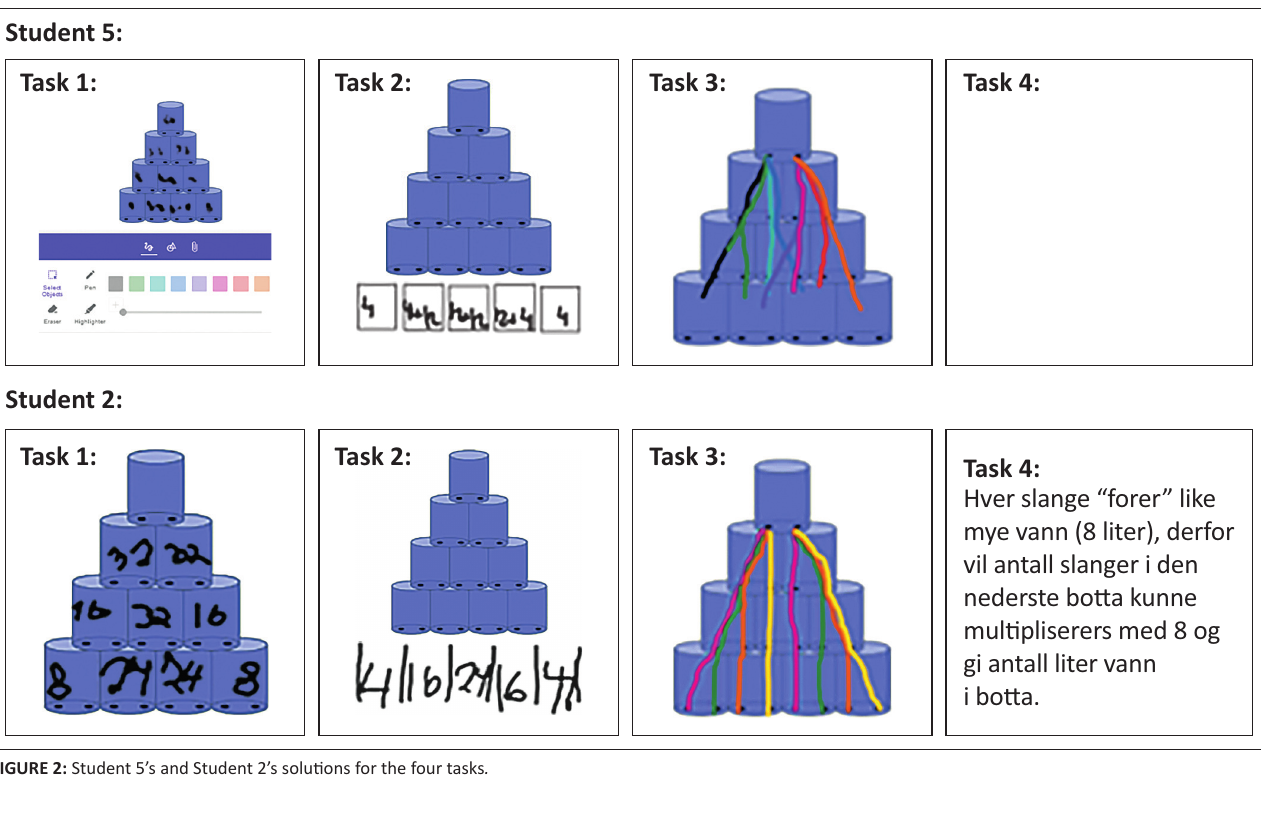
FIGURE 2: Student 5’s and Student 2’s solutions for the four tasks .